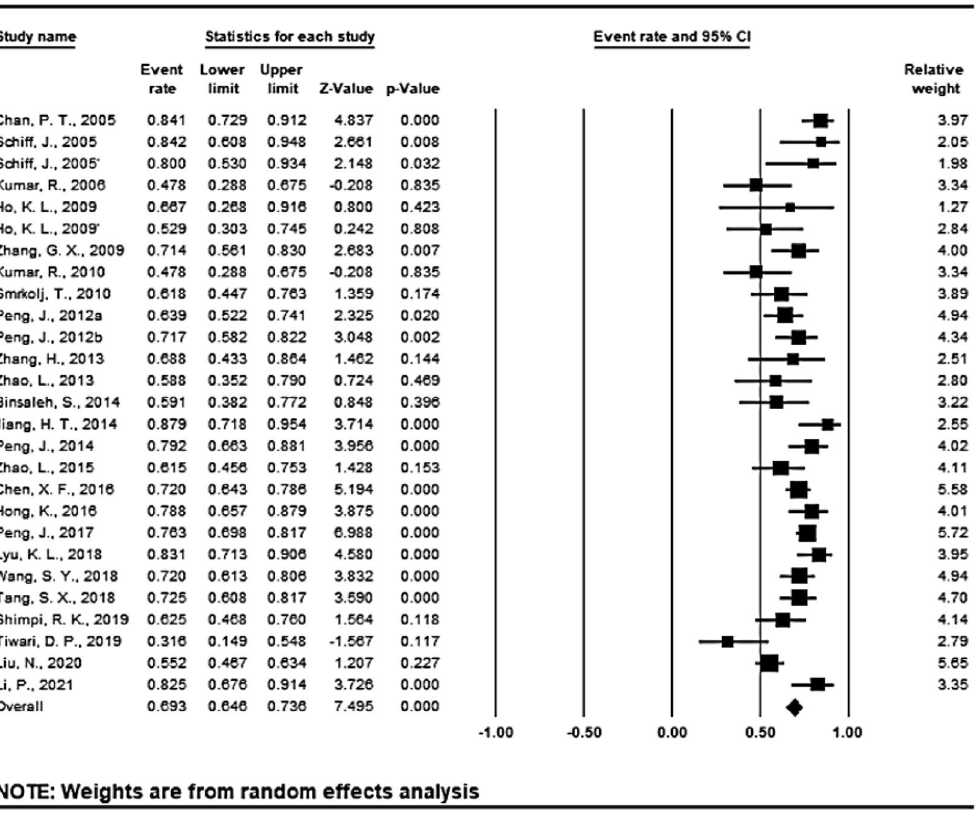
Figure 3. Forest plots of overall patency rate; CI confidence interval. Annotation: 2 IVE techniques were reported by Schiff, J. et al. 2 and Ho, K. L. et al. 7 respectively, and were statistically analyzed separately in this analysis.